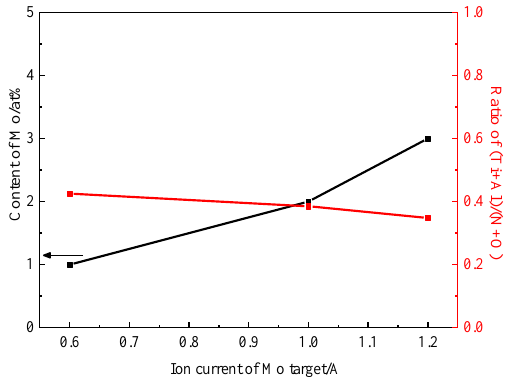
Figure 5. Effect of target current on Mo content and ratio of (Ti + Al)/(N + O).